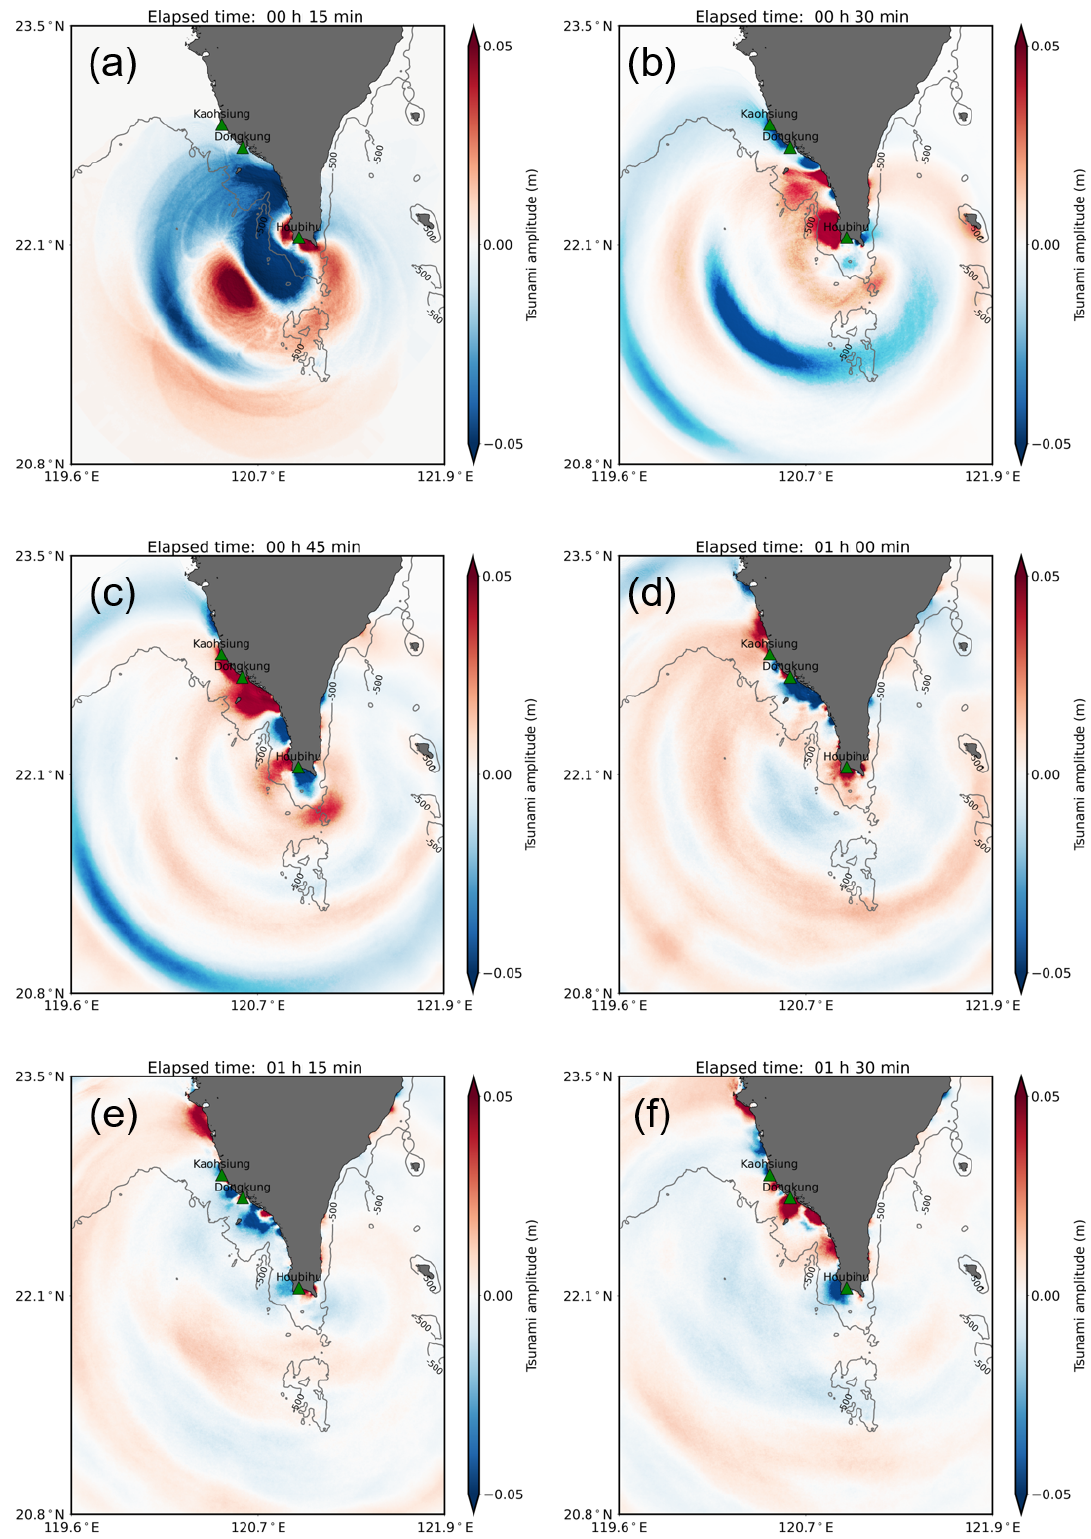
Figure 22. Tsunami propagation snapshots from the numerical experiment EXP1. The tide gauge stations are plotted as green triangles. The bathymetry contour at a depth of 500m is shown as a solid gray